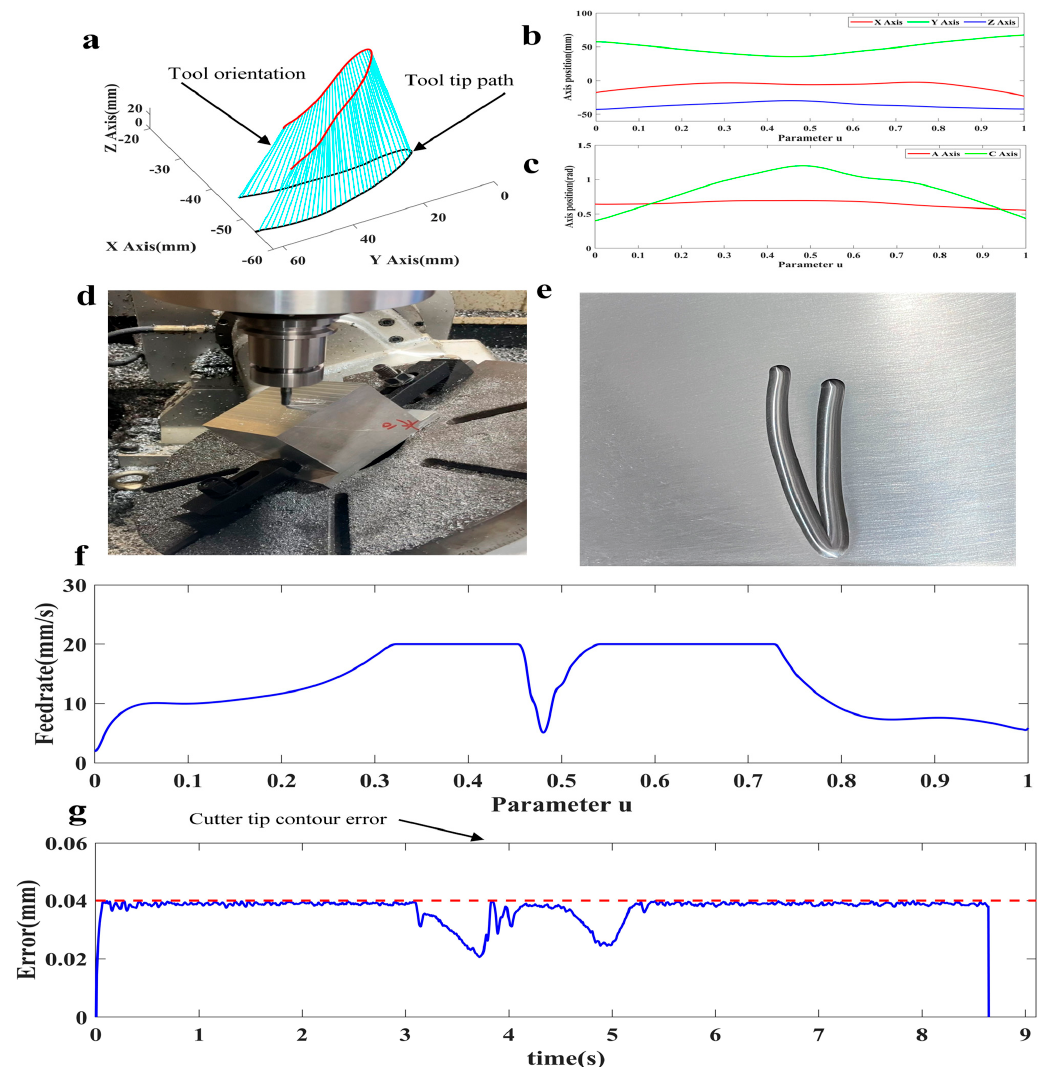
Figure 8. Experimental results of five-axis end milling: ( a ) toolpath is expressed by dual NURBS; ( b ) position curve of linear axes; ( c ) position curve of rotary axes; ( d ) five-axis milling process; ( e ) machined part with the optimized feedrate; ( f ) optimized feedrate curve with the constraint of cutter tip contour error; ( g ) experimental measurement results of cutter tip contour